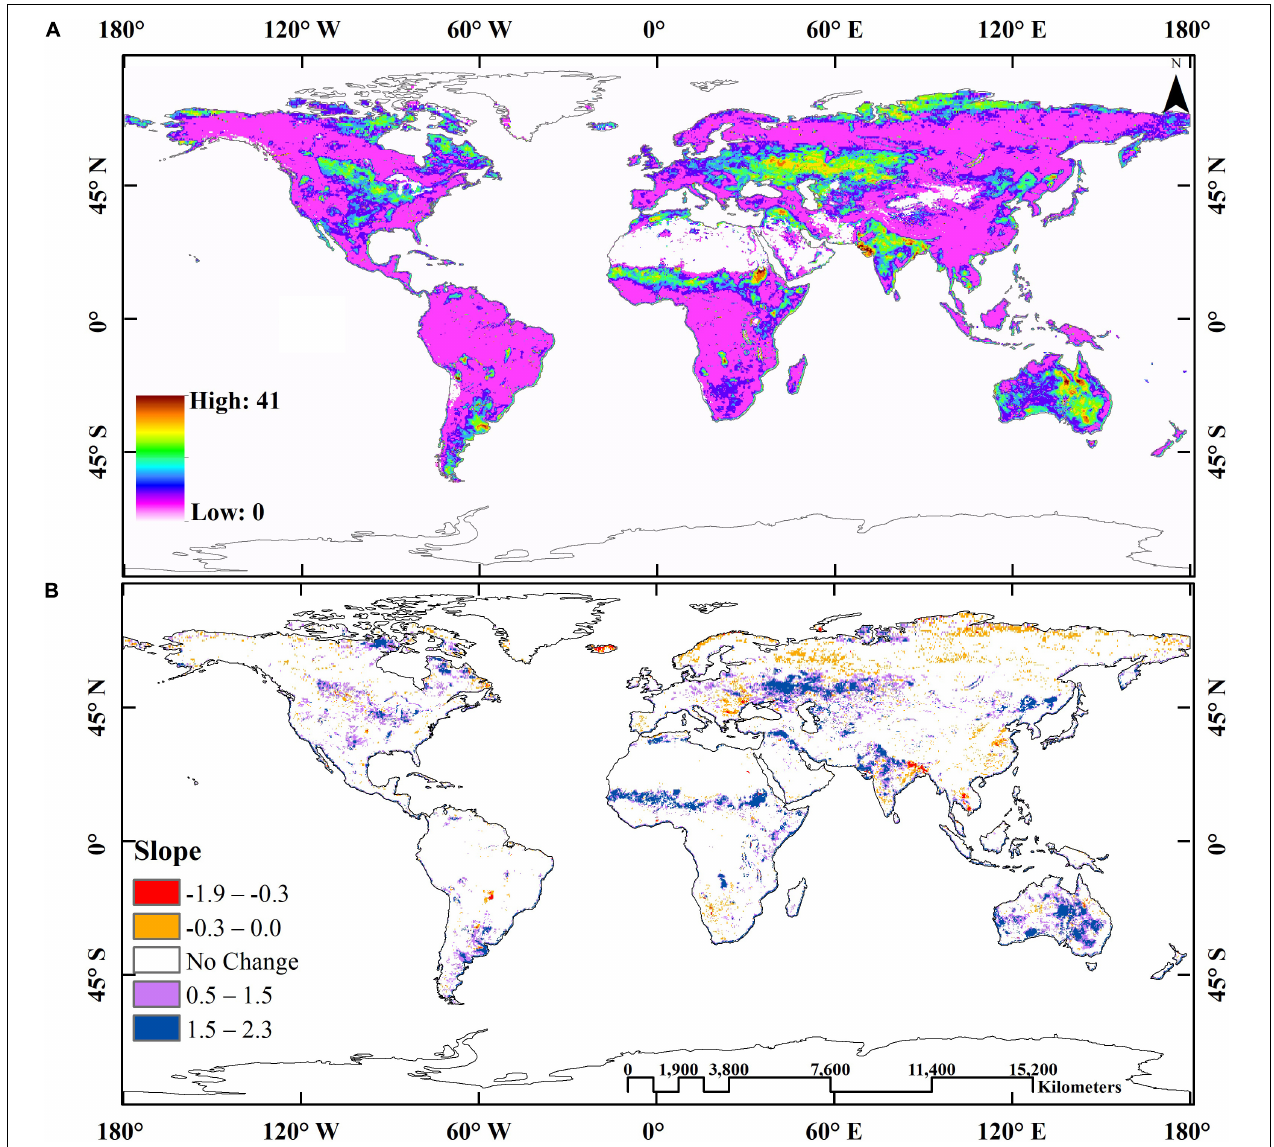
FIGURE 4 | (A) Global distribution of interannual variability during 1995–2015 (fractional percentage) from SWAMPS dataset indicating the extent of deviation (standard deviation of maximum inundation fraction) observed in global inundation patterns. (B) Interannual maximum surface inundation anomaly trend (with the slope values presenting fractional percentage/year) during 1995–2015 from SWAMPS